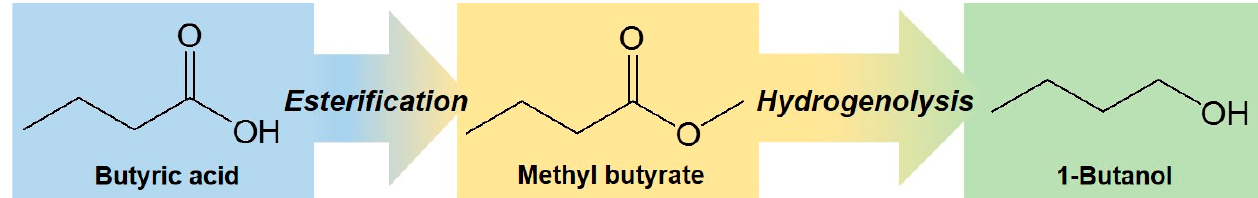
Figure 3. Strategic two-step process for the production of n-butanol from butyric acid. Reprinted from Cho et al. [75], Copyright (2019), with permission from Elsevier.